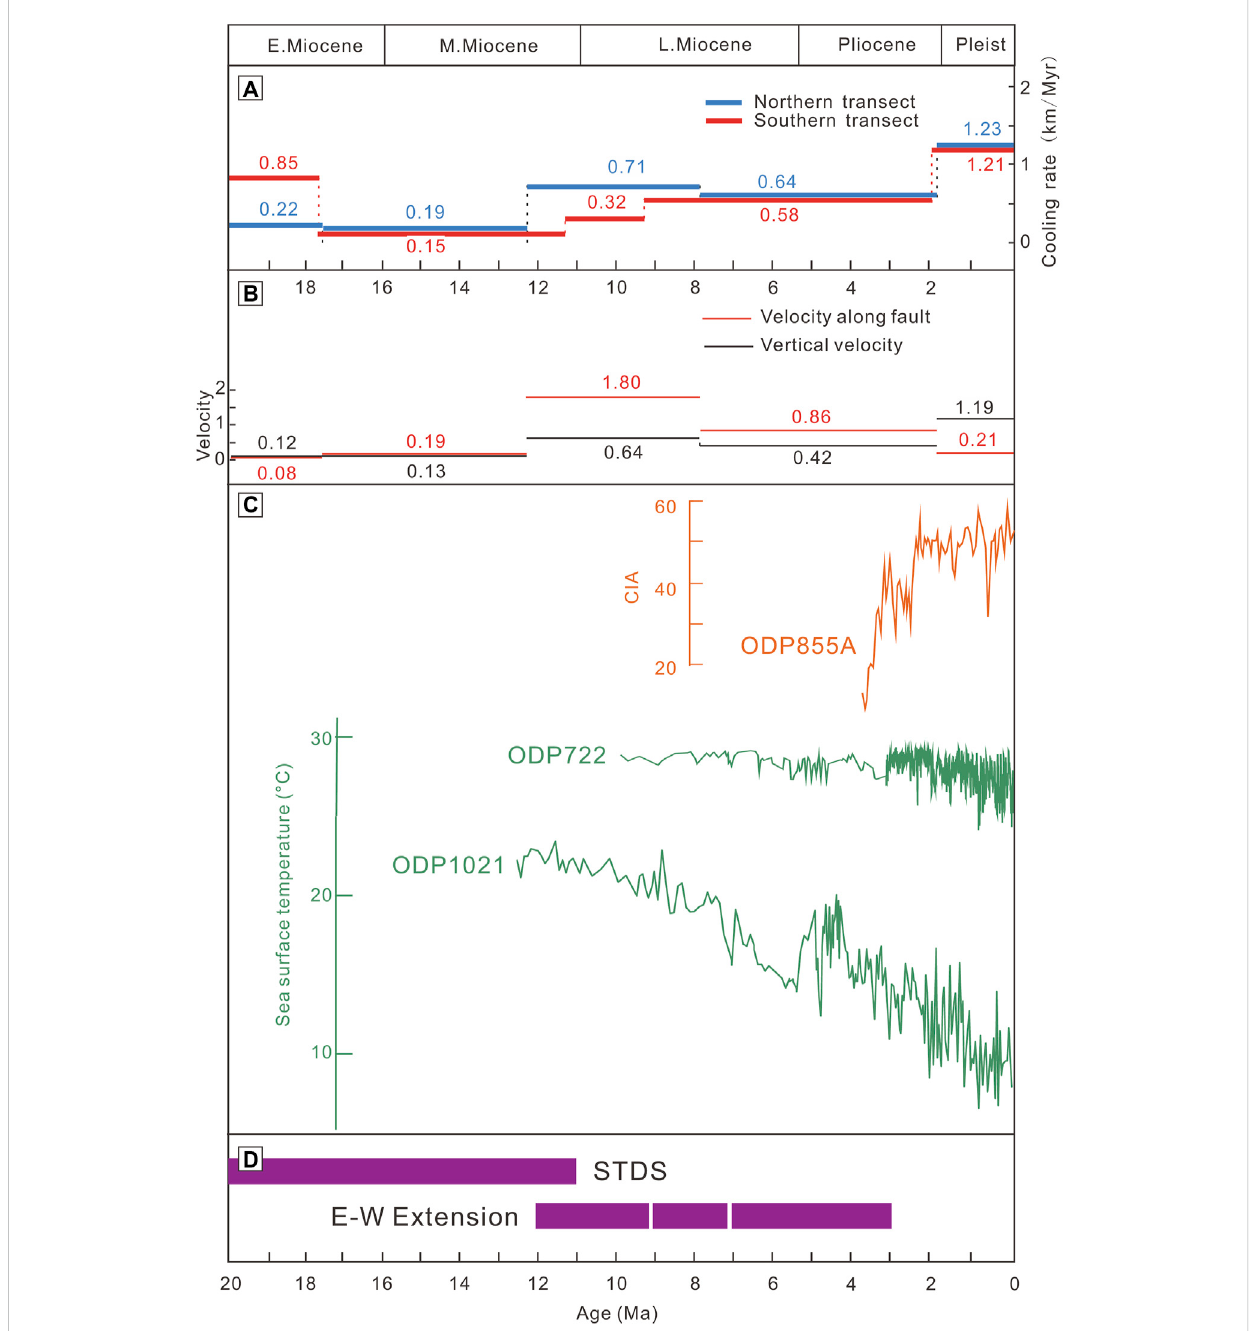
FIGURE 8 Graphical representation ofthebest- fi tinversionresult ofthecooling rate fromtheexhumation scenario (A) and/orvelocity fromfault-exhumation scenario (B) ; (C) the chemical index of alteration (CIA) data from Ocean Drilling Program (ODP) Hole 885A, North Paci fi c Ocean (Zhang., et, al. 2019), the seasurfacetemperaturedatafromOceanDrillingProgram(ODP)Hole722inArabianSeaand1021inNorthPaci fi cOcean(HerbertandLawrence,2016); (D) Tectonic activities in the Kangmar-Yadong area, southern Tibet. Timing of the STDS (Webb et al., 2017; Dong et al., 2021) and E ‒ W extension (Dong et al., 2021; Bian et al., 2022; Wang et al., 2022).